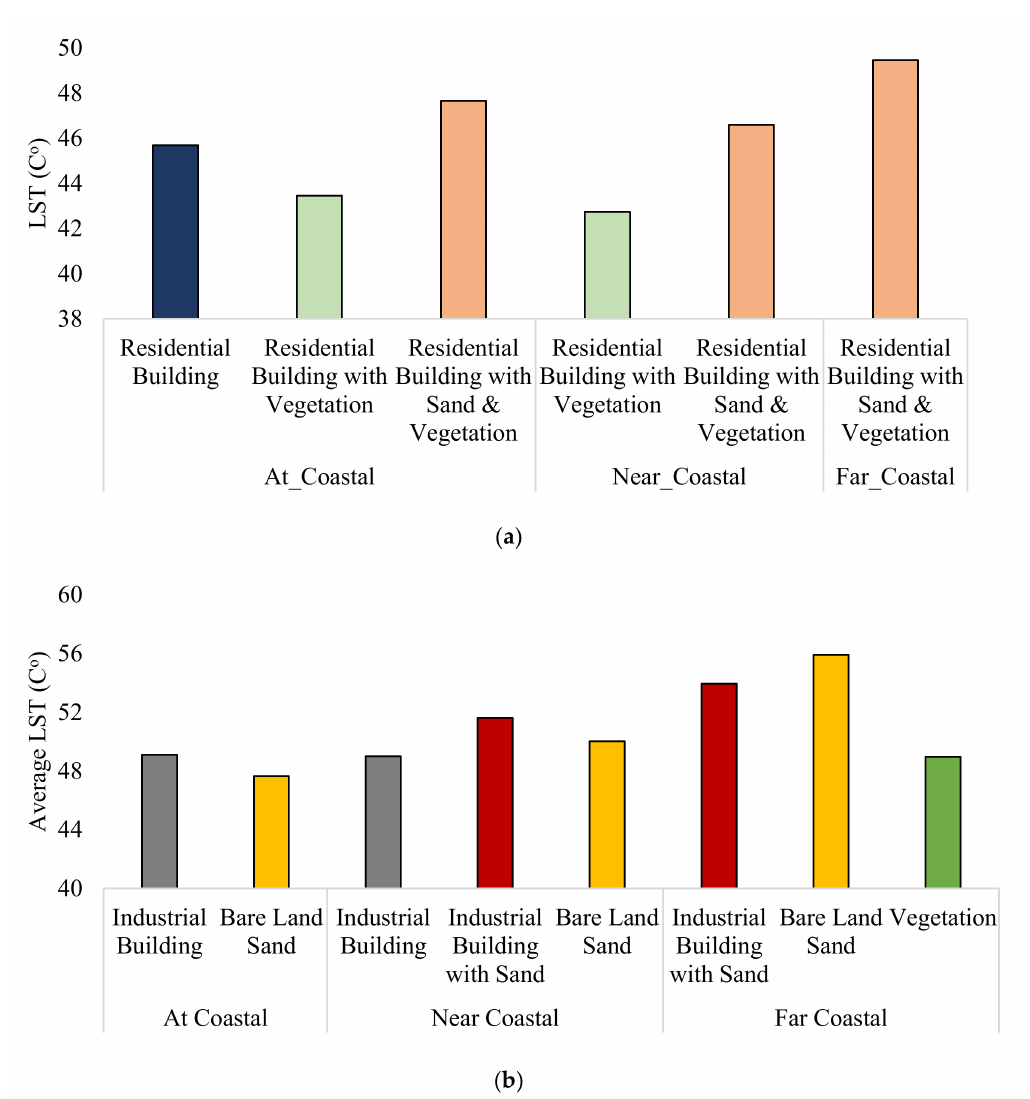
Figure 16. Zonal Statistics at Selected Districts located in the Study Area. ( a ) Zonal Statistics of Residential Buildings; ( b ) Zonal Statistics of Industrial Buildings, Bare Land Sands, and